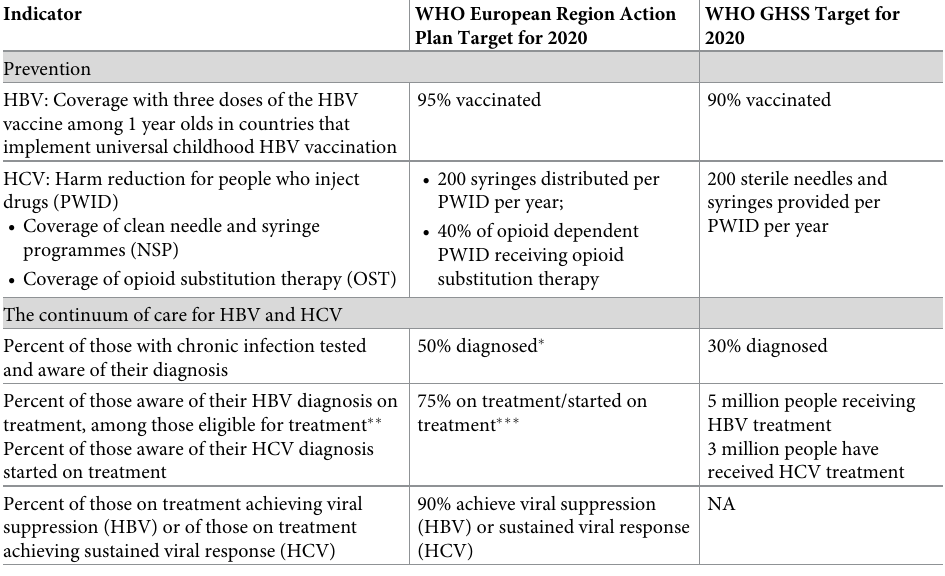
Table 1. Core indicators for measuring progress towards the SDG targets and related 2020 targets.